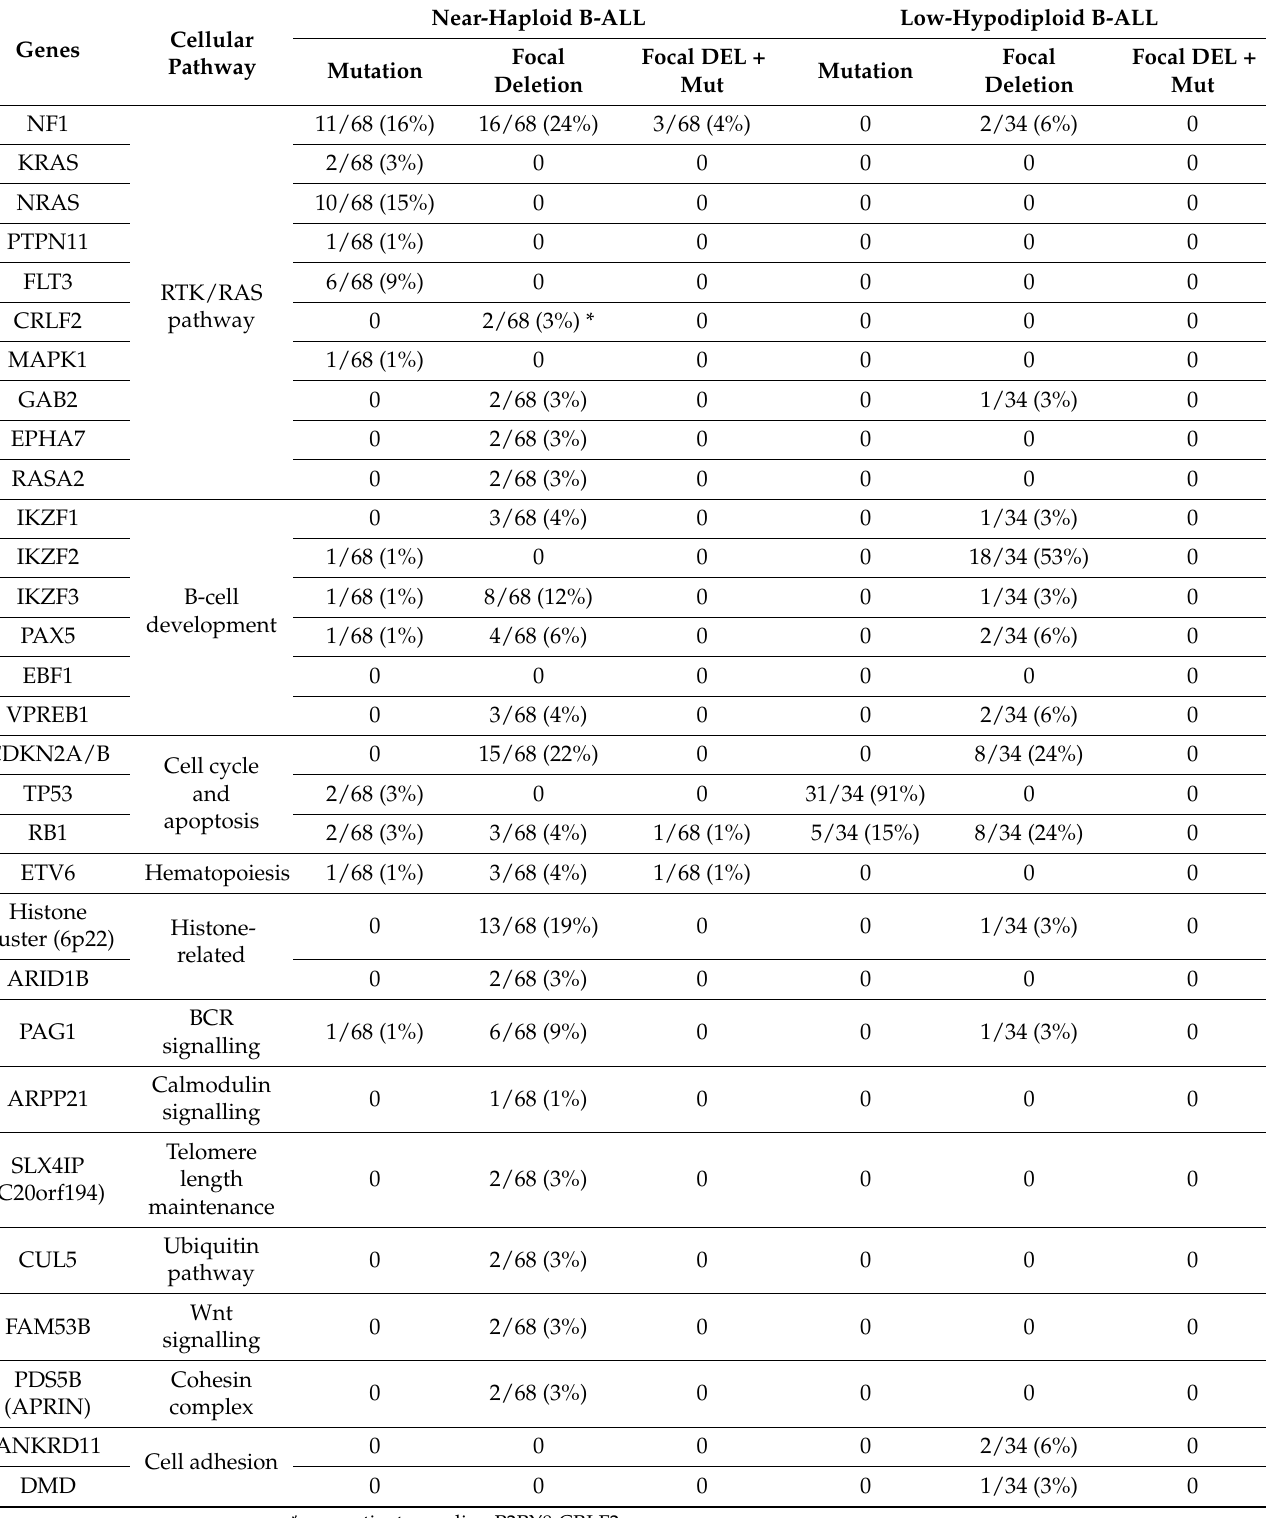
Table 4. Molecular characteristics of hypodiploid <40 chromosomes B-ALL (Adapted from Holmfelt et al., 2013